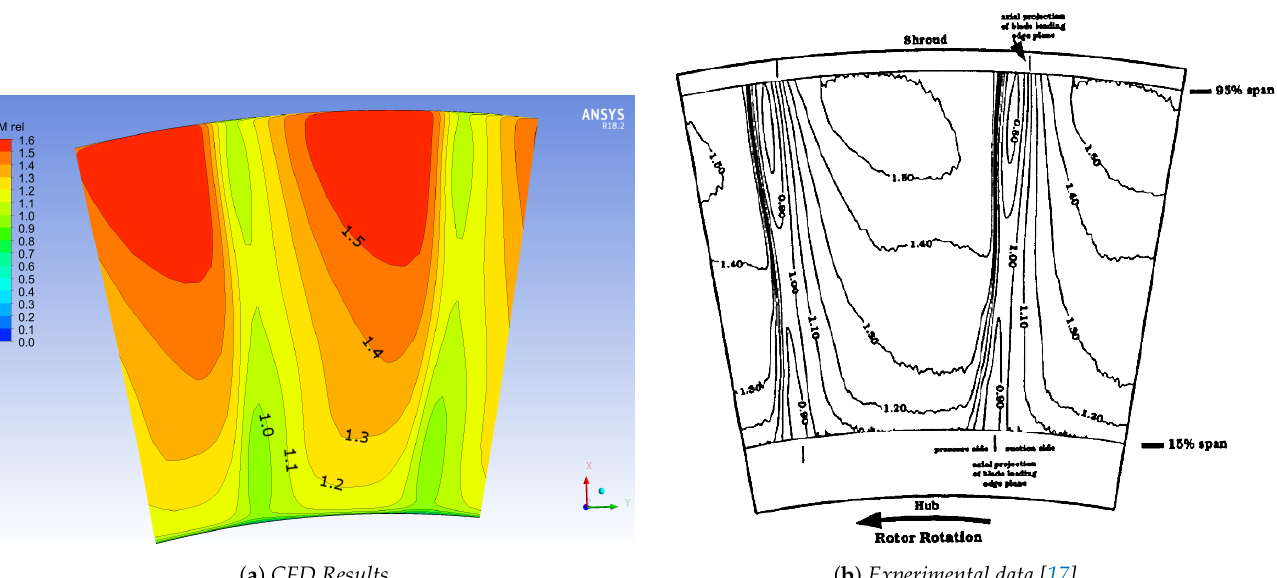
Figure 10. Span-wise distribution at 98% m Choke .